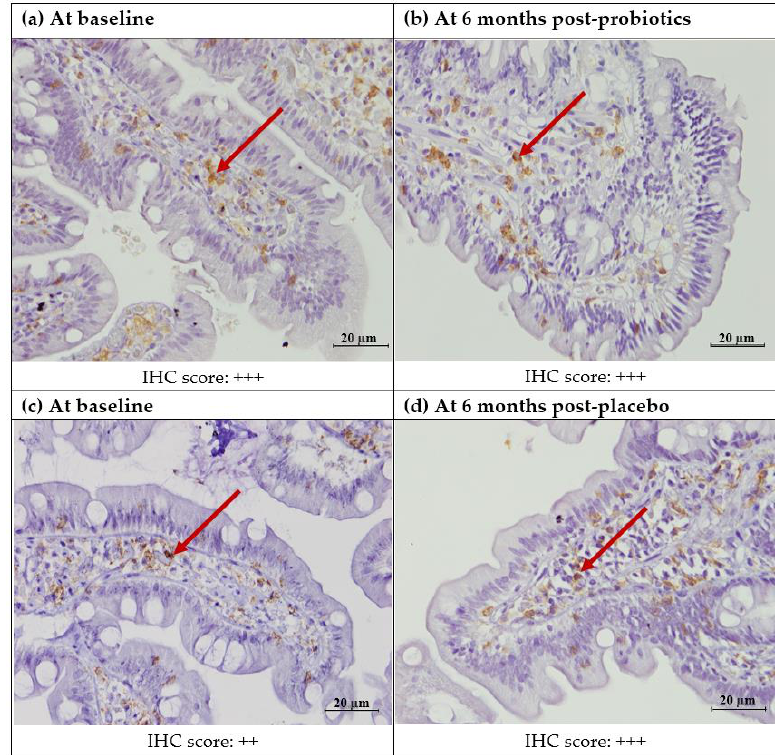
Figure 2. Immunohistochemicalstaining of CD4+ protein in the duodenal mucosa (CD4+, 400X). ( a ) Duodenal mucosa of a patient with NAFLD at baseline. ( b ) Duodenal mucosa of a patient with NAFLD after 6 months of probiotics. ( c ) Duodenal mucosa of a patient with NAFLD at baseline. ( d ) Duodenal mucosa of a patient with NAFLD after 6 months of the placebo. The arrows show brownish staining of the CD4+ T lymphocytes in the lamina propria. Semi-quantitatively, both the probiotics and placebo groups did not show any difference in the percentage of staining before and after the intervention. Staining score: 0: no staining; +: focal staining; ++: regional staining; and +++: no loss.